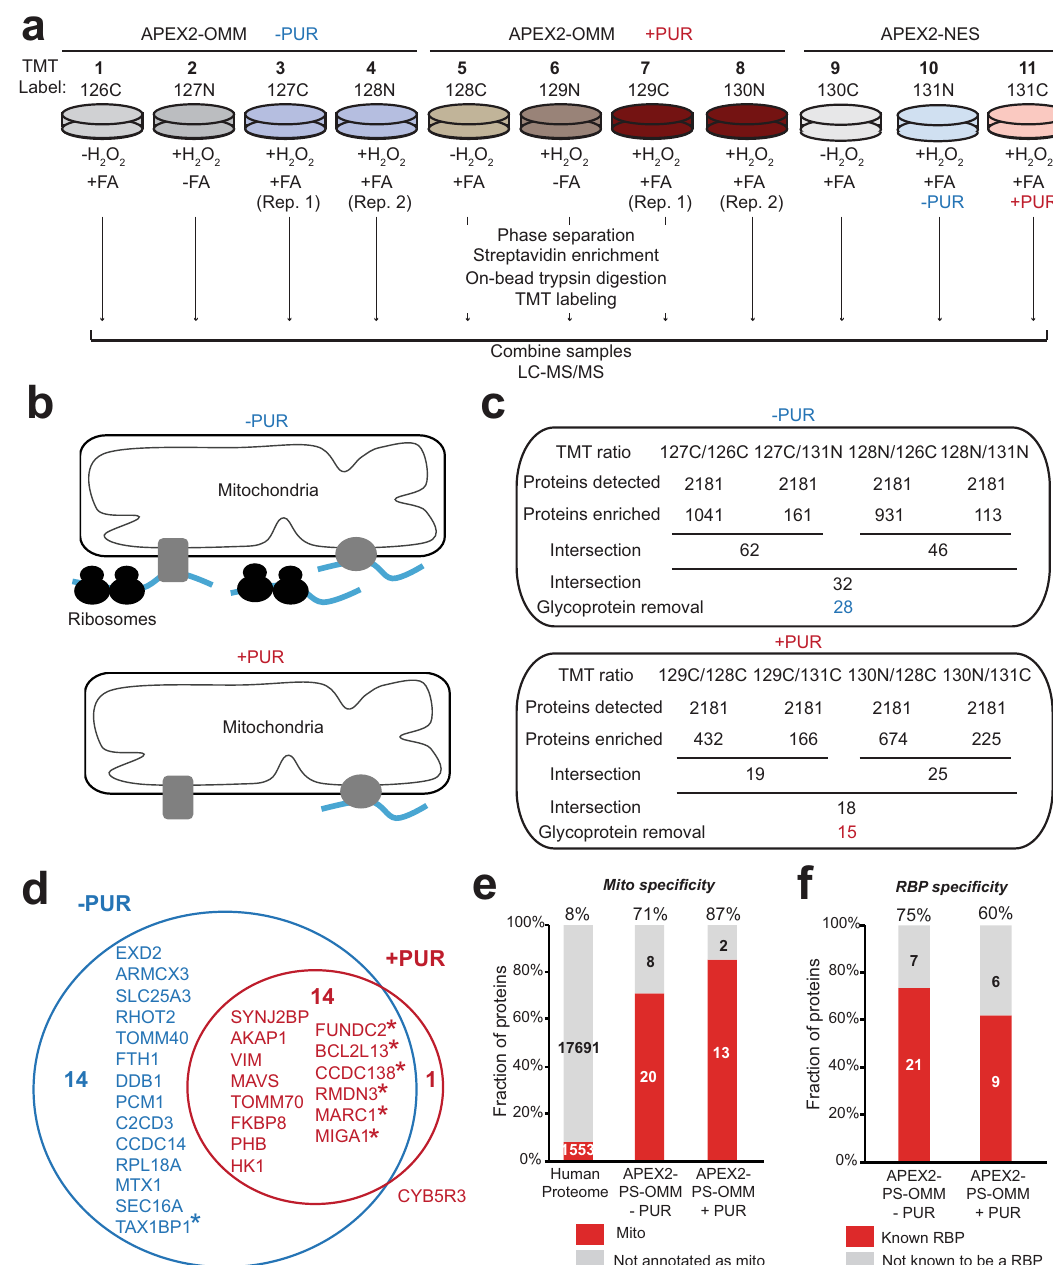
streptavidin-based enrichment 74 ) to selectively detect newly syn- thesized proteins. Figure 6g shows that SYNJ2BP KO clearly impaired the translation of all fi ve proteins during the PUR recovery phase. In a control experiment, SYNJ2BP had no impact on the total protein level or newly synthesized protein level of